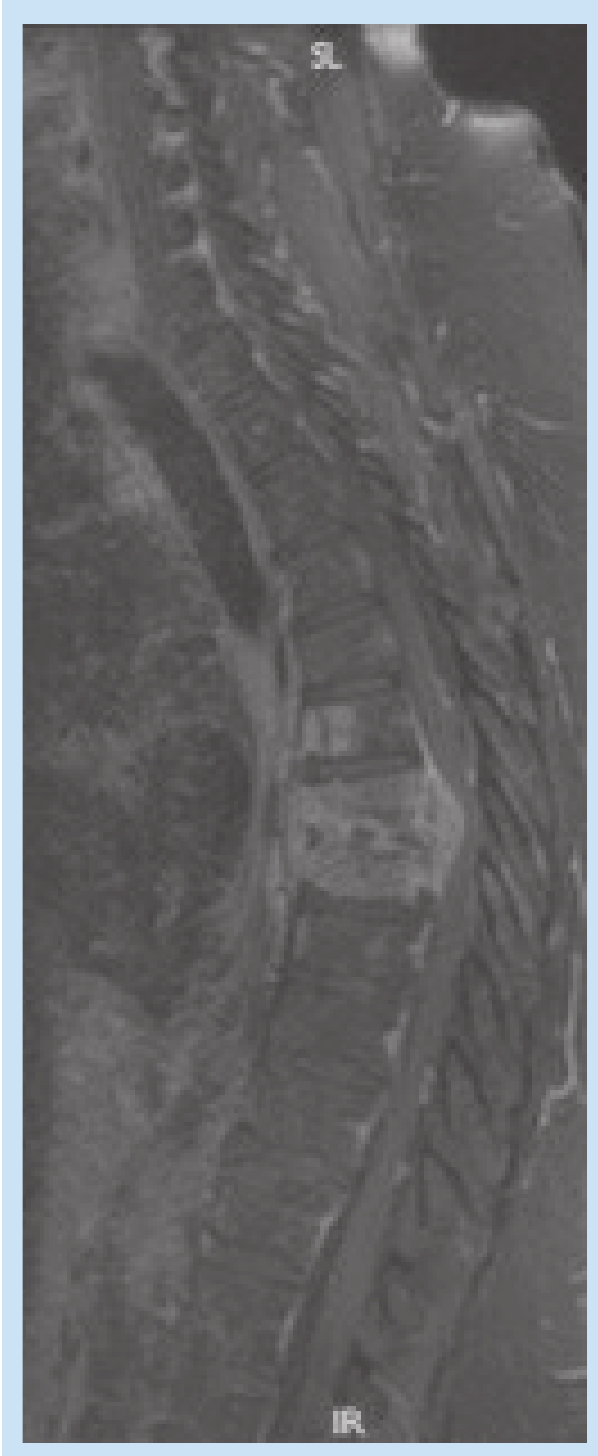
Fig 3d. T1 postcontrast sagittal image. Enhancement of the affected vertebrae.